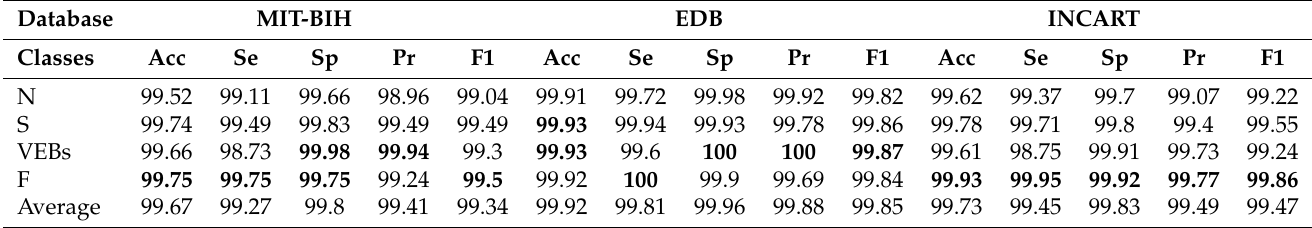
Table 6. The performance of the MPA-RF classifier on all the databases’